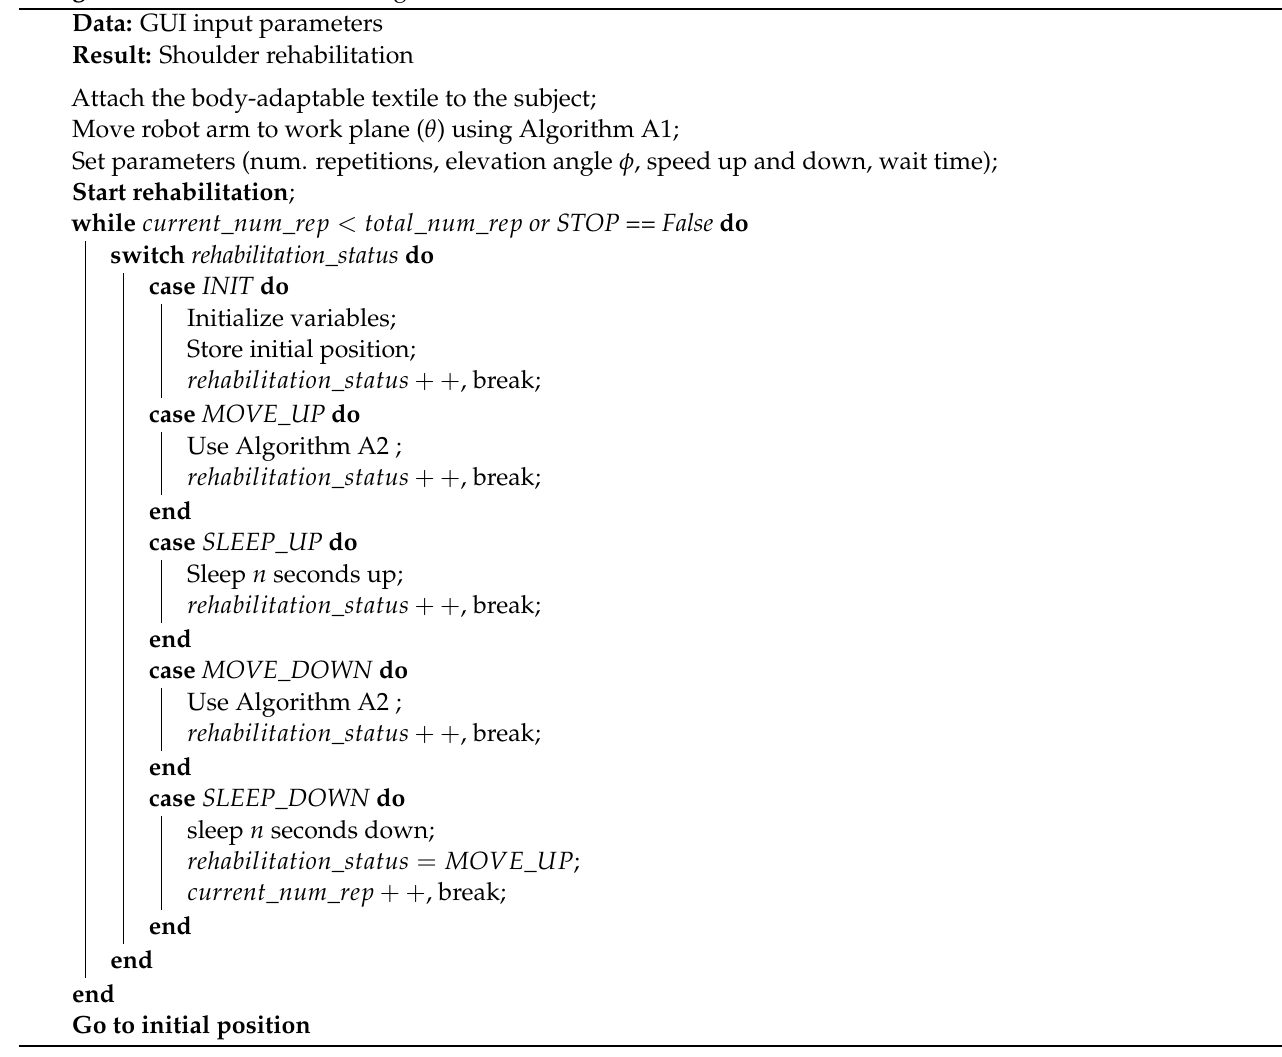
Algorithm A3: State machine algorithm for shoulder movement Data: GUI input